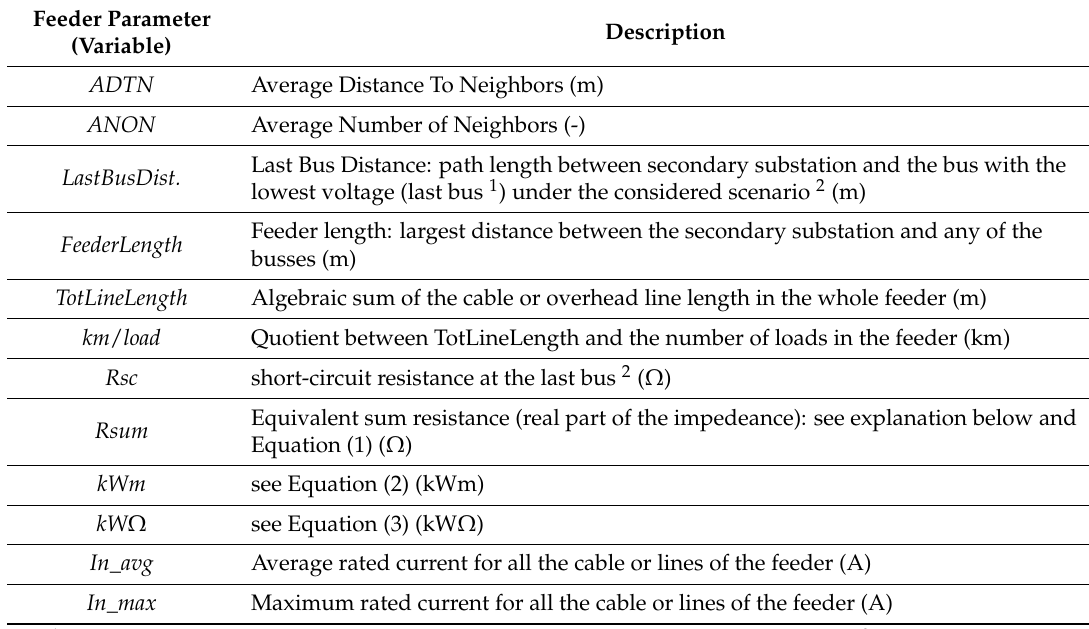
Table 2. Feeder parameters (variables) to be used for the clustering analysis and the